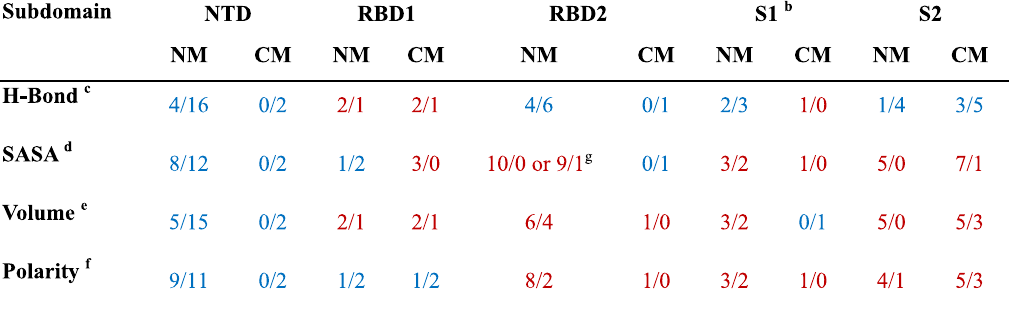
a Six dominant mutations include five VOC variants (Alpha, Beta, Gamma, Delta and Omicron) and one VOI variant (Mu); the symbol "/" is preceded by the total number of DP residues with an increase in physicochemical parameters, followed by that with a decrease in parameters; when the number of residues with rising physicochemical parameters is dominant, it is shown in red, otherwise in blue; NM and CM are abbreviations for non-conserved and conserved mutations,